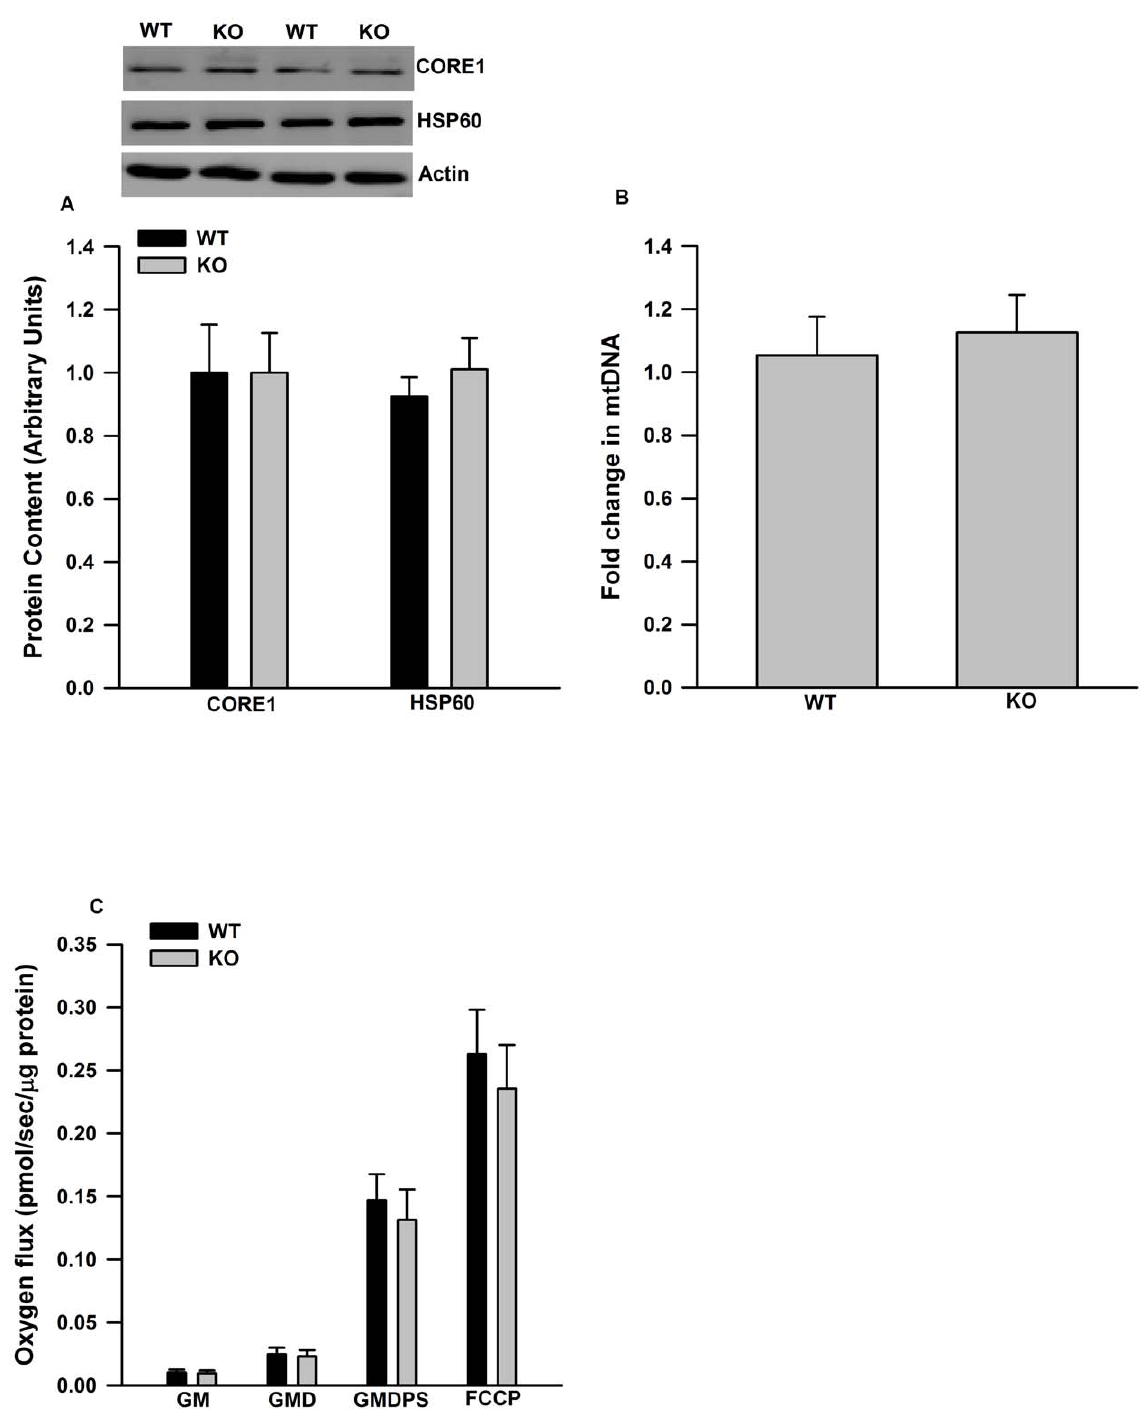
Figure 4. Mitochondrial content and respiration are not altered in epididymal adipose tissue from IL-6 2 / 2 mice fed a HFD. A) Mitochondrial marker proteins, B) mtDNA content and C) mitochondrial respiration are similar between genotypes. Data are presented as means + SE for 8–10 animals per group. Western blot images are given above the quantified data in A. Relative mtDNA content is normalized to genomic MCT1 (monocarboxylate transporter 1) DNA content and expressed as fold differences compared to the WT group in B. Mitochondrial respiration was measured by high-resolution O2 consumption. GM (glutamate, malate), GMD (glutamate, malate, ADP), GMDPS (glutamate, malate, ADP, pyruvate, succinate). doi:10.1371/journal.pone.0051233.g004 associated with a lower expression of proteins that are involved in clear differences in IL-6 responsiveness between depots, a finding the IL-6 receptor signaling complex including GP130 and the complementing previous work reporting greater IL-6 secretion alpha subunit of the IL-6 receptor [38]. These results highlight from abdominal versus subcutaneous adipose tissue [18].